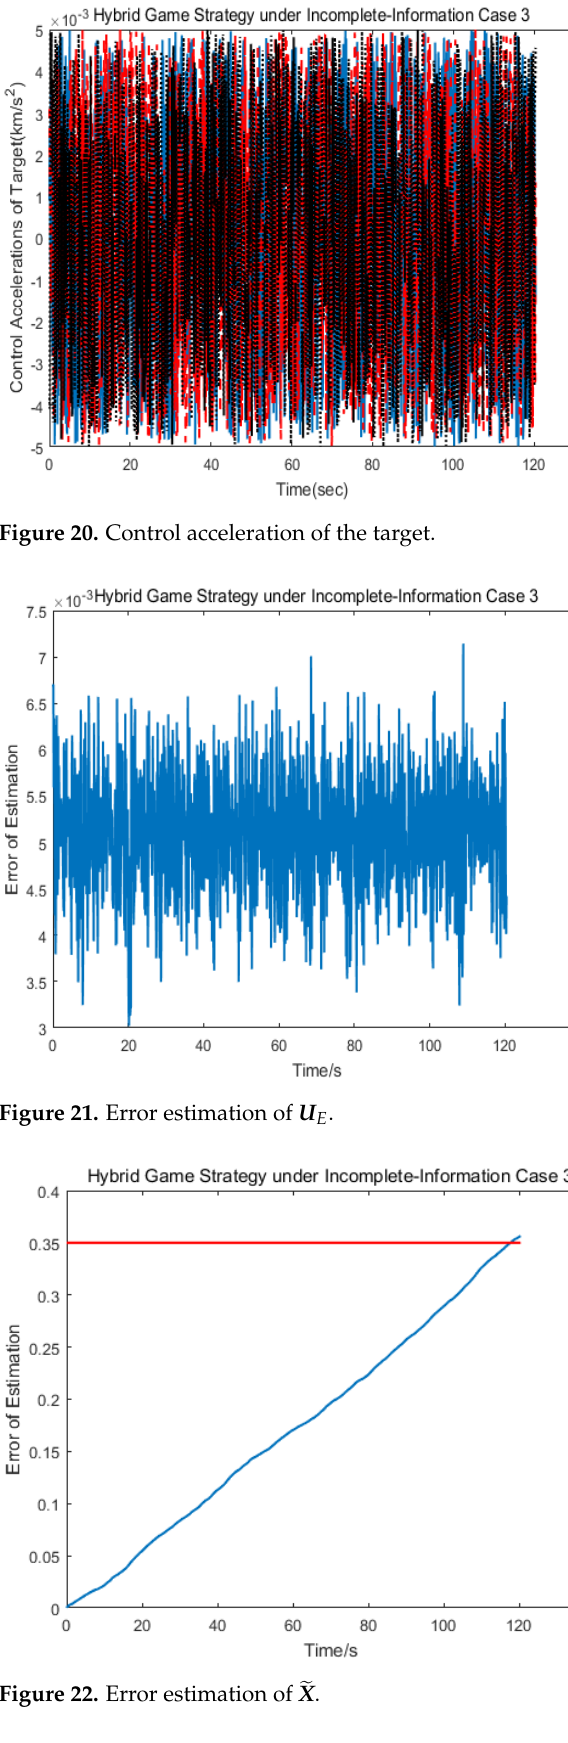
Figure 19. Control acceleration of the pursuer.